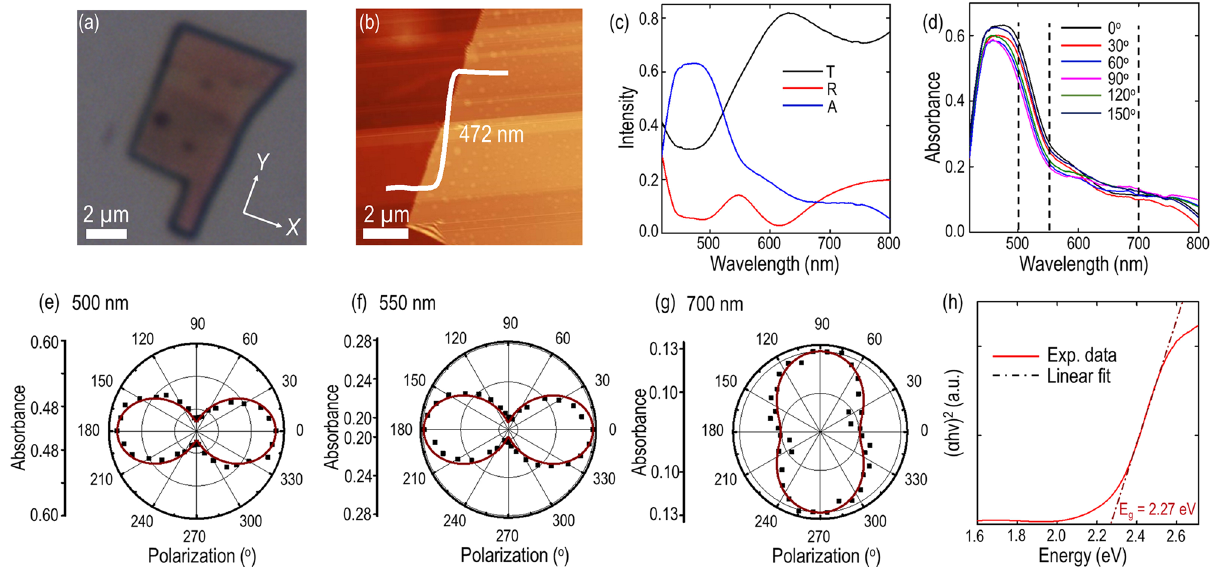
Figure 4. Anisotropic linear optical response and linear dichroism transition. ( a ) Optical transmission microscope image of the investigated gerstleyite flake. ( b ) Captured AFM image of the flake. ( c ) Recorded reflectance ( R ), transmittance ( T ), and absorbance ( A ) spectra. ( d ) Measured polarization-resolved absorbance spectra under incident linear polarization angle from 0° to 180°. ( e – g ) Evolution of absorbance as a function of the incident polarization angle at three different wavelengths at 500, 550 and 700 nm indicated with black dashed lines in ( d ). The measured data points are denoted with black squares, whereas the theoretical fits are signified with brown solid lines. ( h ) Measured Tauc plot and direct optical band gap